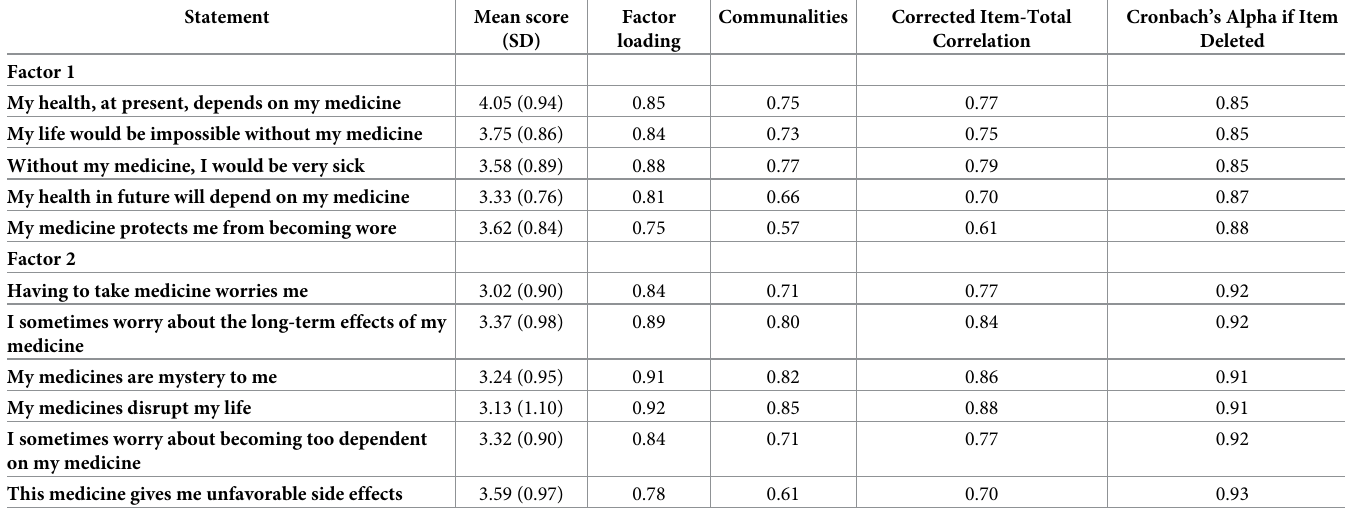
Table 3. Scores, factor loadings, communalities, corrected item total correlation, and Cronbach’s alpha if item deleted for BMQ items.